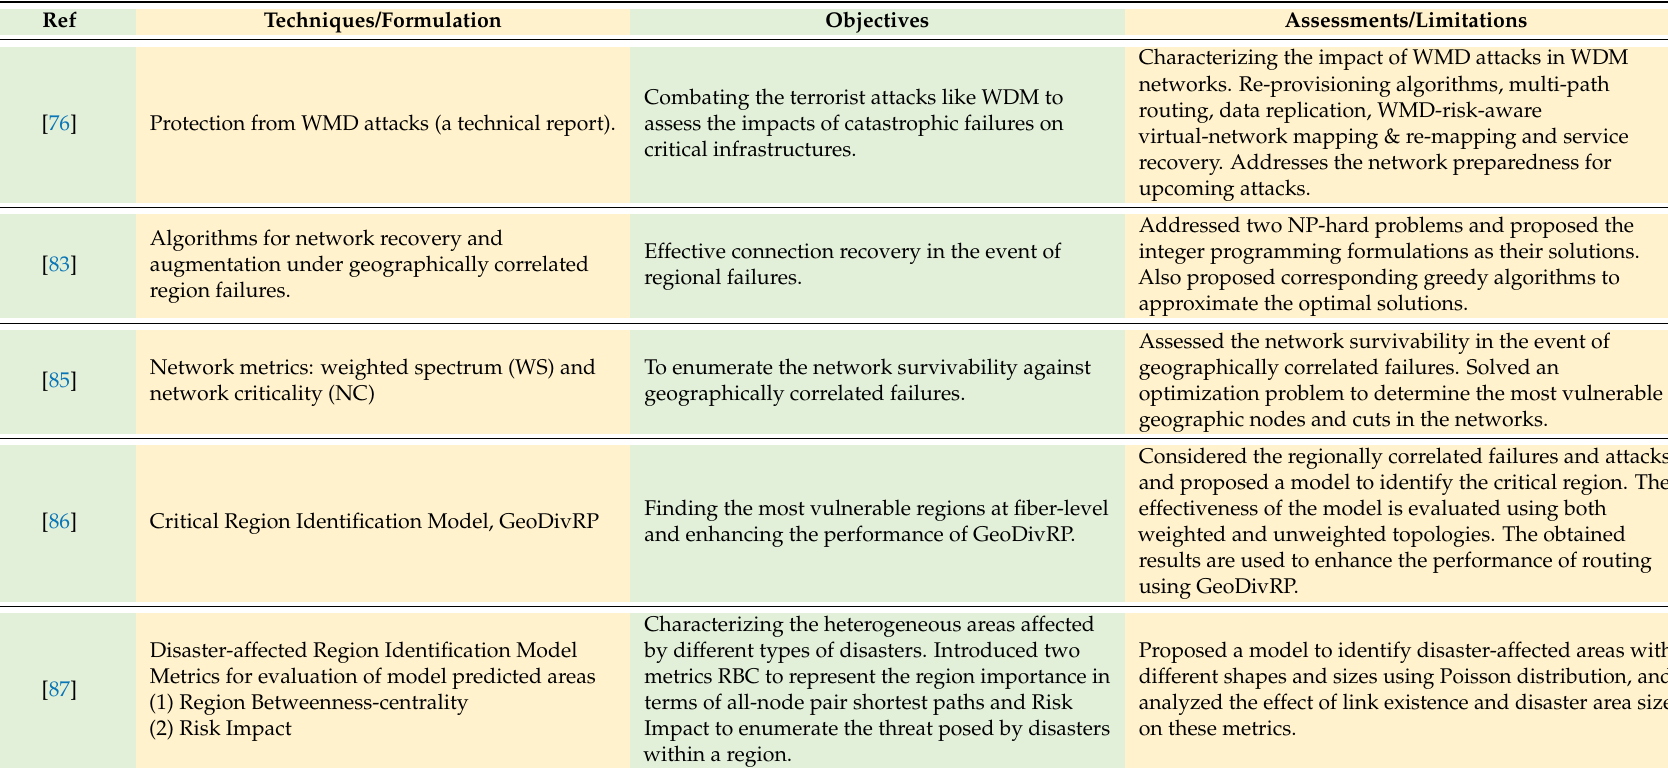
Table 1. Close comparison of large-scale attack and disaster survivability